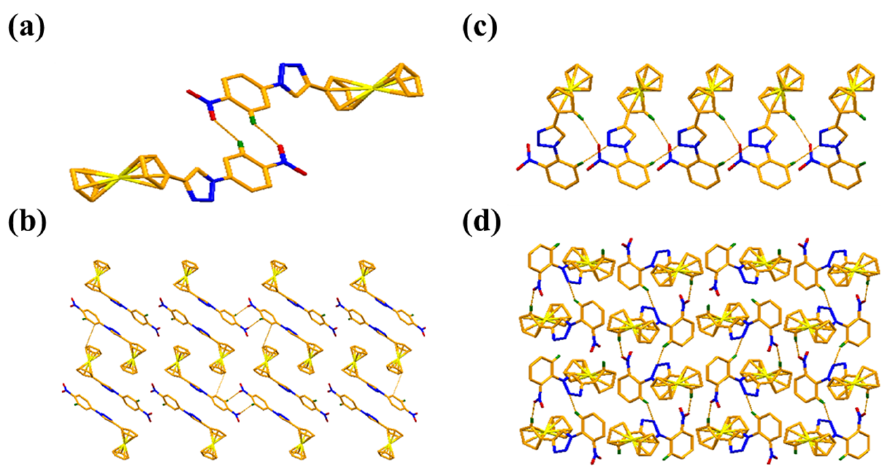
Figure 2. A view of the formation of dimer due to C—H ⋯ O interactions ( a ) and a packing diagram along the b -axis with π ⋯ π interactions ( b ), shown as pink dashed lines in X1 . A view of the formation of a polymeric structure of X5 due to C—H ⋯ N interactions ( c ) and packing diagram along the a -axis ( d ) are shown as pink dashed lines. Table 2. Hydrogen-bond geometry (Å, °) of compounds X1 and X5 .